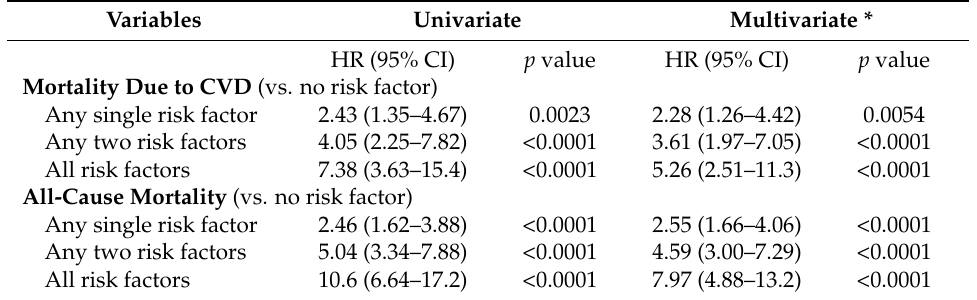
Table 5. Combined predictive value of abnormal ABI, GNRI, and CRP for CVD- and all-cause mortality.